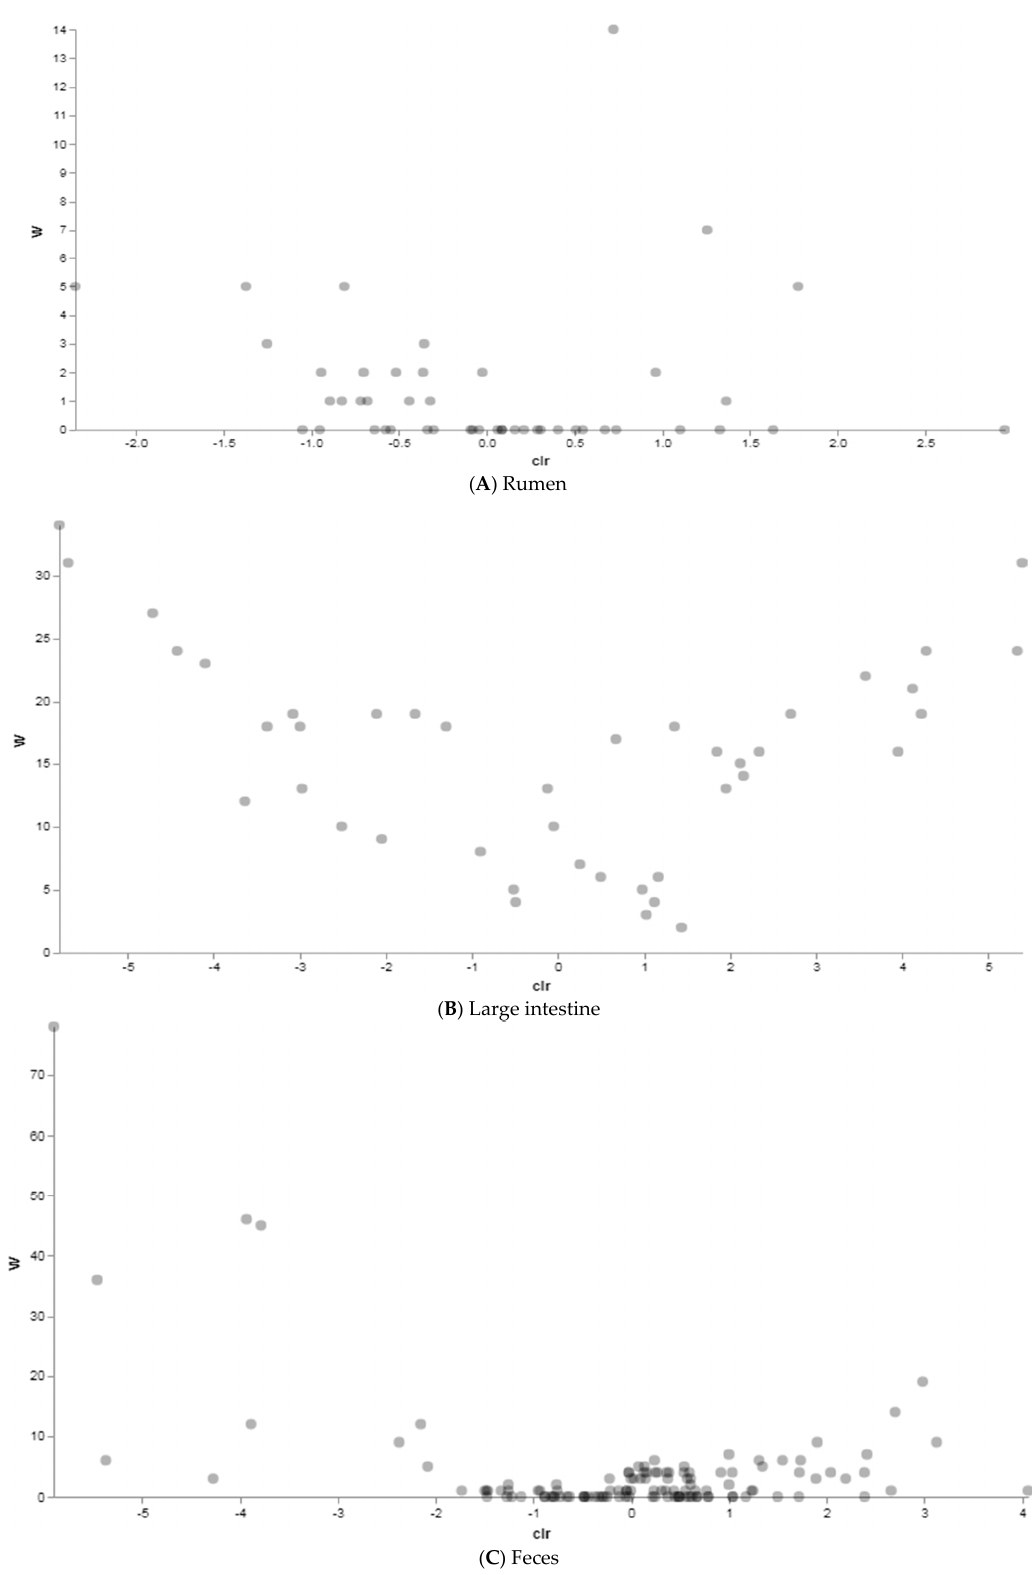
Figure 7. ANCOM results between traditionally ( n = 10) and alternatively ( n = 10) fed water buffaloes. Dots represent features identified by ANCOM as differentially abundant between groups. Statistically significant differentially abundant taxa are represented by the dots in the upper corners of the graph.